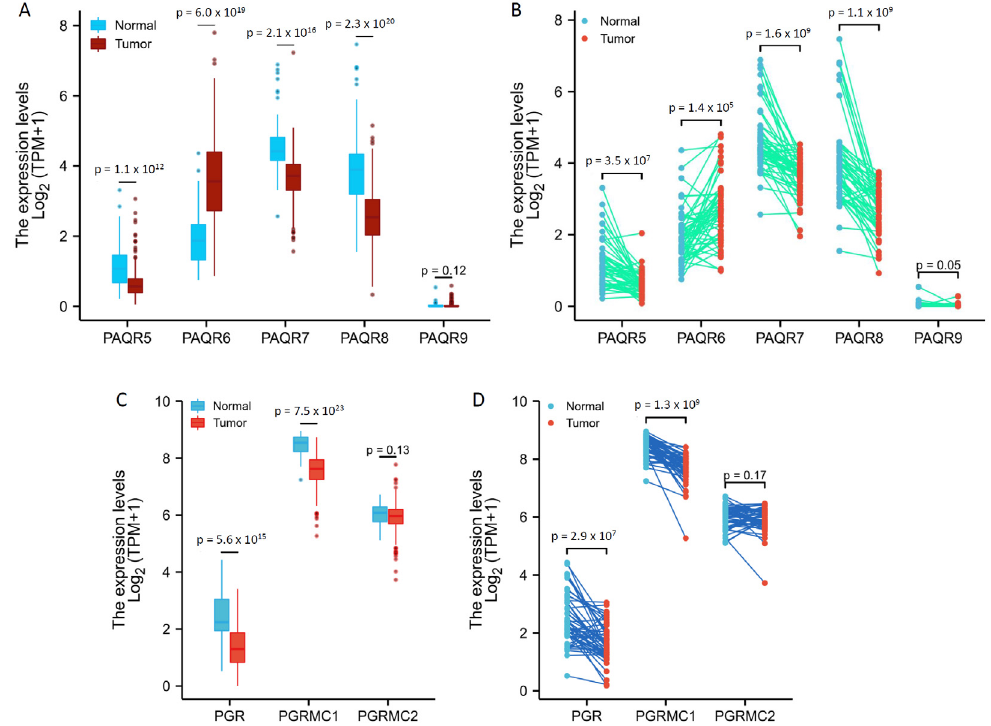
Figure 2. Aberrant expression of PAQR genes in prostate cancers. Gene expression levels were analyzed using the RNA-seq dataset from the TCGA project. Group comparison ( A , C ) and pair-wise comparison ( B , D ) were conducted in 499 or 52 cases, respectively. The p -values were derived from the Wilcoxon rank-sum test for group comparison or Wilcoxon signed-rank test for pair-wise comparison.